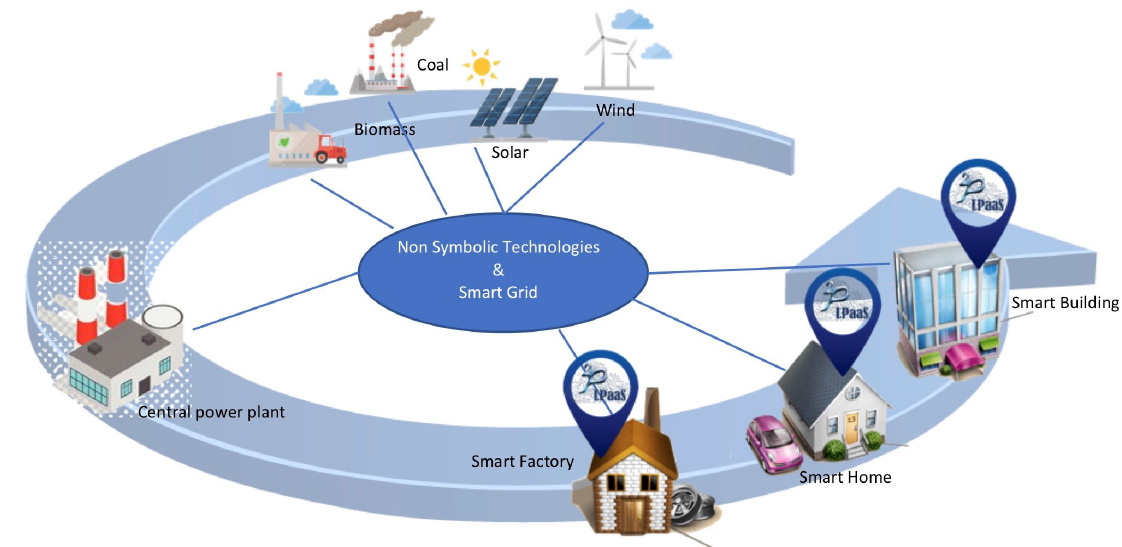
Figure 6. The LPaaS smart energy application